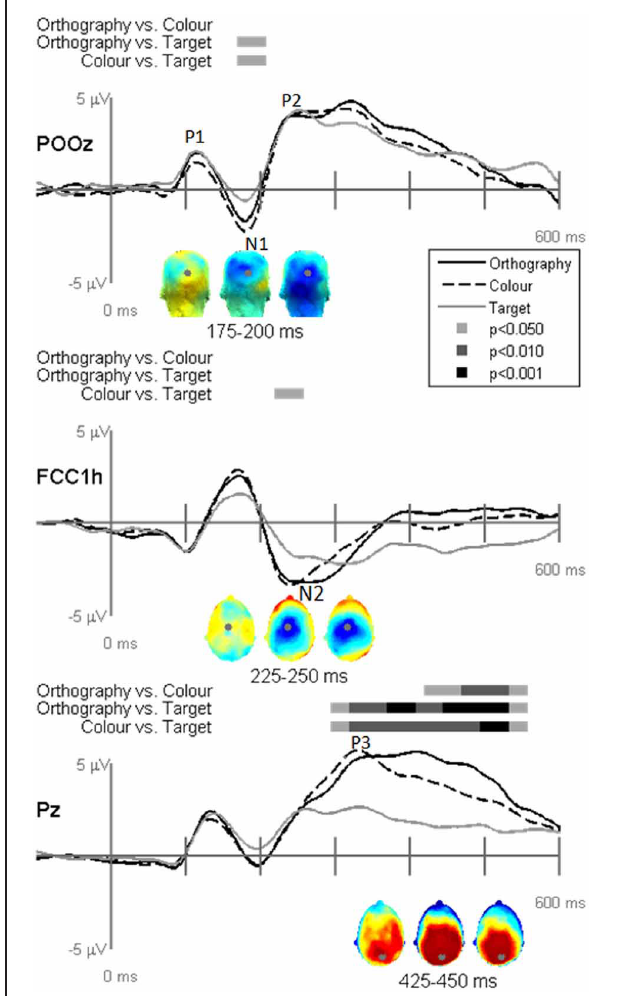
FIGURE 4 | Grand-mean evoked potentials for Stimulus effects averaged across tasks (Orthography, Color, and Target) at electrodes PO10h, PO9h, and P6. Bars above the waveforms designate intervals of significant differences between letters and pseudoletters at p < 0 . 05, p < 0 . 01, and p < 0 . 001. Scalp topographies plotted under the waveforms reflect difference waveforms averaged across the designated intervals shown for left, posterior, and right views. The gray dots in the topographies reflect the electrode location for the waveforms plotted above. 1 , 112; p = 0 . 0177). No other ANOVA effects or interactions for P2 amplitudes were found to be significant ( p > 0 . 2). Peak